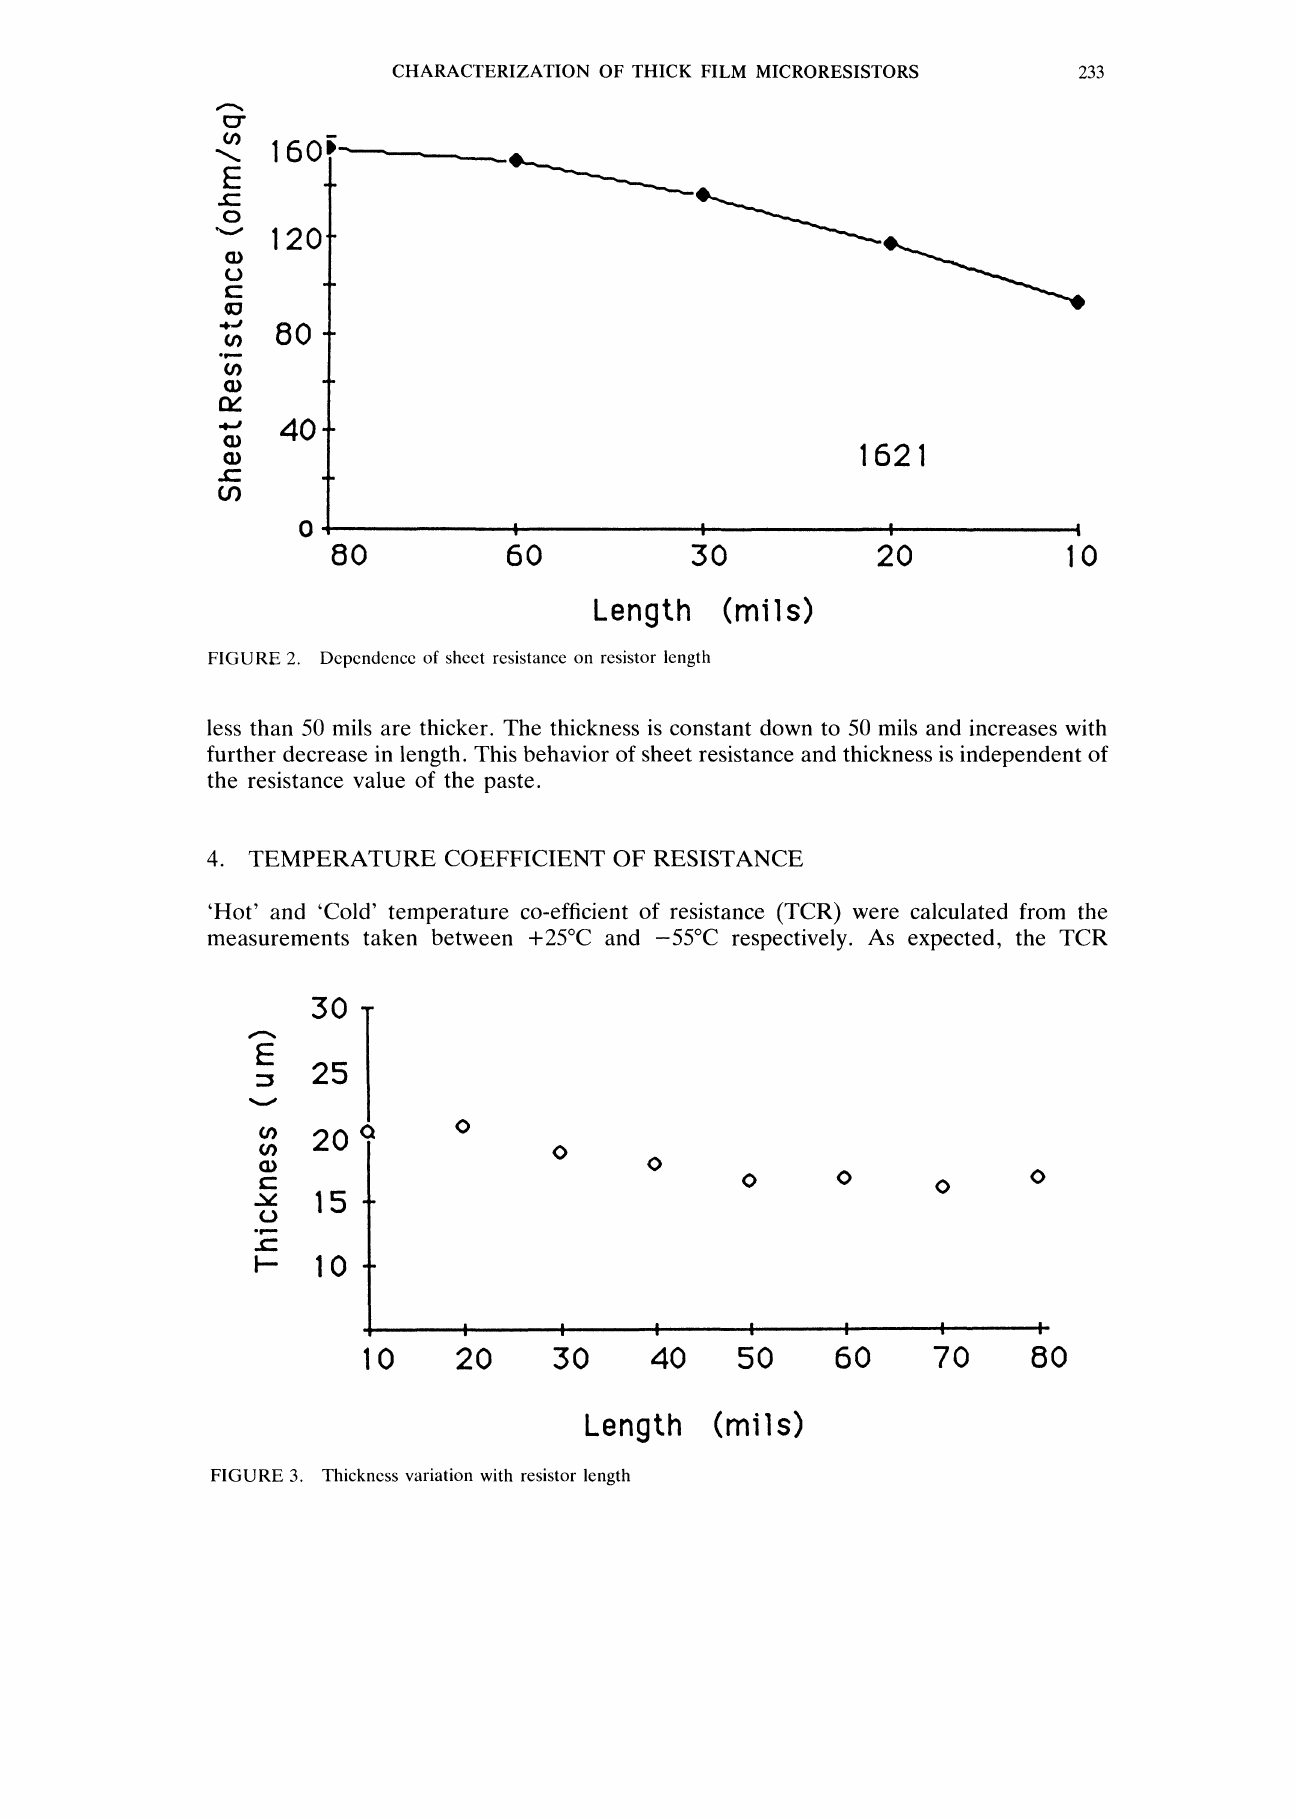
FIGURE 3. Thickness variation with resistor